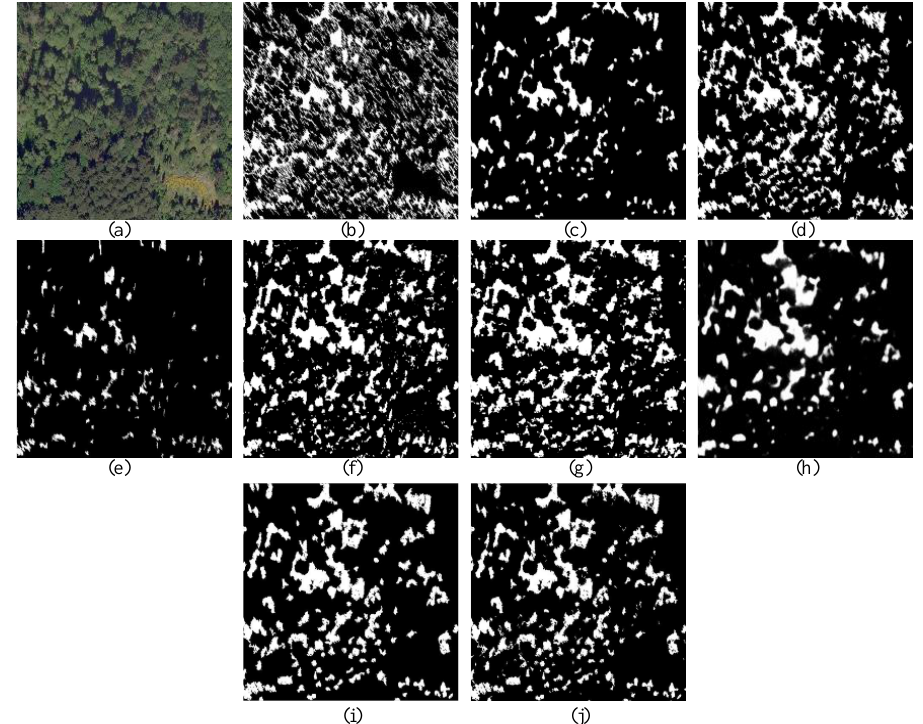
Figure 11. Vegetation shadow detection in Kitsap district : ( a ) original image; ( b ) SRHI; ( c ) NB; ( d ) HTD; ( e ) C1C2C3; ( f ) U-Net method; ( g ) Segnet method; ( h ) BDRAR method; ( i ) DLA-PSO method; ( j ) ground truth.